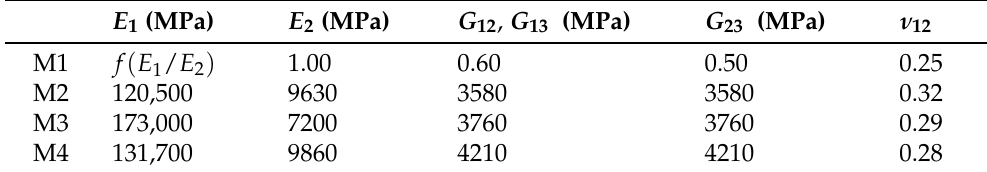
Table 1. Material elastic properties.